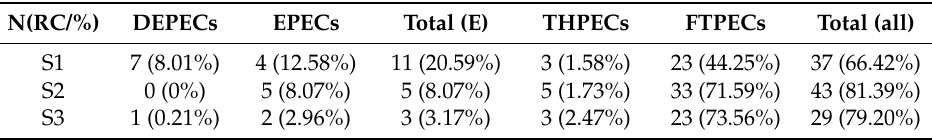
Table 4. The statistical results of 2-(2-phenylethyl)chromone